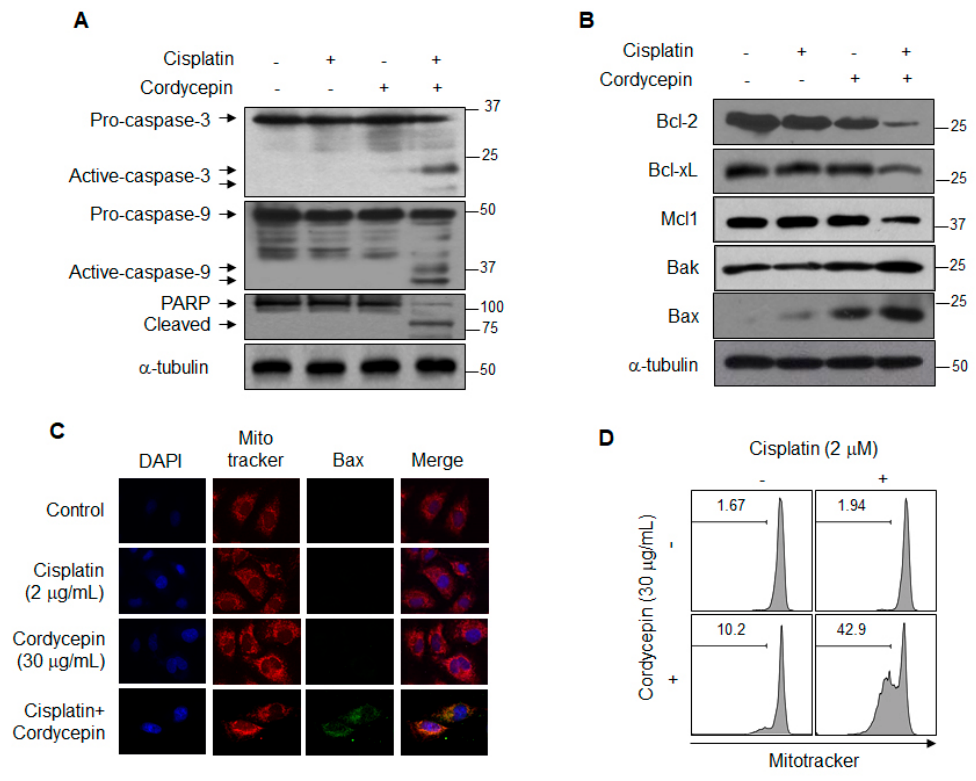
Figure 2. Induction of cordycepin ‐ mediated apoptosis via the mitochondrial pathway in cisplatin ‐ treated T24R2 cells. T24R2 cells were treated with 30 μ g/mL cordycepin and/or 2 μ g/mL cisplatin for 24 h, and whole cell extracts were analyzed by Western blotting using the indicated antibody against caspase ‐ 3, ‐ 9, or PARP cleavage ( A ), anti ‐ apoptotic or pro ‐ apoptotic proteins ( B ). α‐ tubulin was used as a loading control. T24R2 cells treated with cisplatin and/or cordycepin were immunostained with anti ‐ active Bax and analyzed using a confocal microscope. ( C ) Active Bax was labeled with an FITC (fluorescein) ‐ conjugated secondary antibody (green), and the mitochondria and nuclei were stained with MitoTracker CMXRos (red) and DAPI (blue), respectively. ( D ) Cells were stained with MitoTracker Red CMXRos, and mitochondrial depolarization was analyzed by flow cytometry. The results are representative of at least two independent experiments.